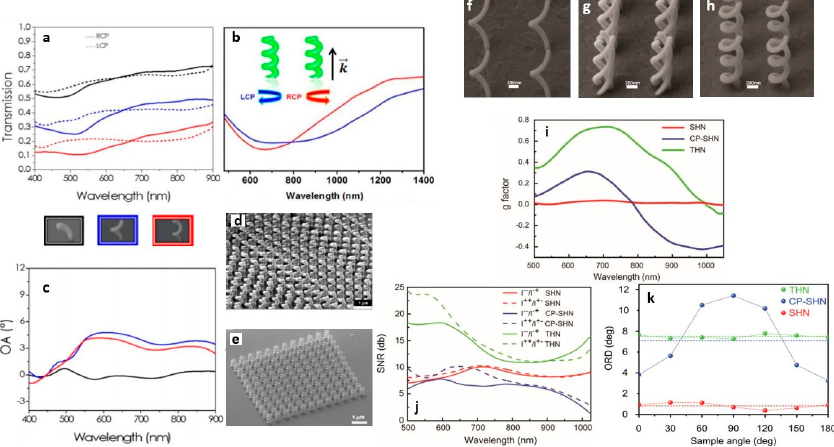
Figure 7. ( a ) Experimentally measured LCP and RCP transmission curves for arrays of nanohelices Pt-based ( a ) with N = 0.5, 1, 1.5 loops (black, blue, and red lines, respectively) and size ED = 300 nm, WD = 100 nm, LP = 500 nm, and VP = 500 nm. Reproduced with permission from [81]. ( b ) Measured transmission spectra of right- and left-handed circularly polar- ized light (red and blue lines, respectively) at normal incidence, of the array in Figure 7d. Reproduced with permission from [69]. ( c ) Measured optical activity for Pt-based helices arrays as in ( a ). Reproduced with permission from [81]. ( d ) SEM image of an array of 20 × 20 nanohelices (5 loops, ED = 400 nm, WD = 130 nm, VP = 300 nm, LP = 700 nm) fabricated by FIBID. Reproduced with permission from [69]. ( e ) SEM images of the THN array with sizes: ED = 375 nm, WD = 110 nm, and VP = 705 nm, LP = 700 nm. Reprinted with permission from [125]. ( f – h ) SEM image of SHN single loop ( f ), THN single loop ( g ), and closely packet SHN triple loop ( h ) arrays grown by FIBID of platinum on the ITO/glass substrate. WD and ED are kept constant at 110 nm and 380 nm, respectively, in the three samples. ( i ) g factor of the d, e, f helices (red line, green line, and blue line, respectively). ( j ) SNR calculated for f, g, h helices shown in Figure 7 (red line, green line, and blue line, respectively). The di ff erent components of transmi tt ed light are I++, I+ − and I −− , I − +, where + refers to LCP and − to RCP light. The fi rst index identi fi es the incident circular polarization, while the second index corresponds to the detected polarization components. ( k ) Optical activity of the crossing point transmission values for the arrays of figure (7f–h). Reproduced with permission from [126].